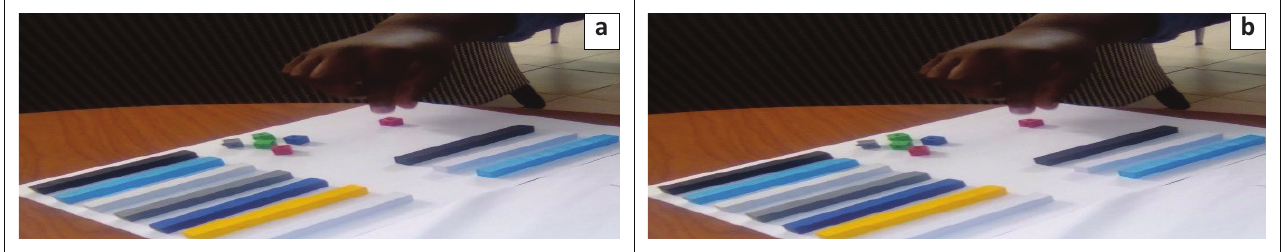
FIGURE 9: (a & b) Sample of students’ written responses to item 8.